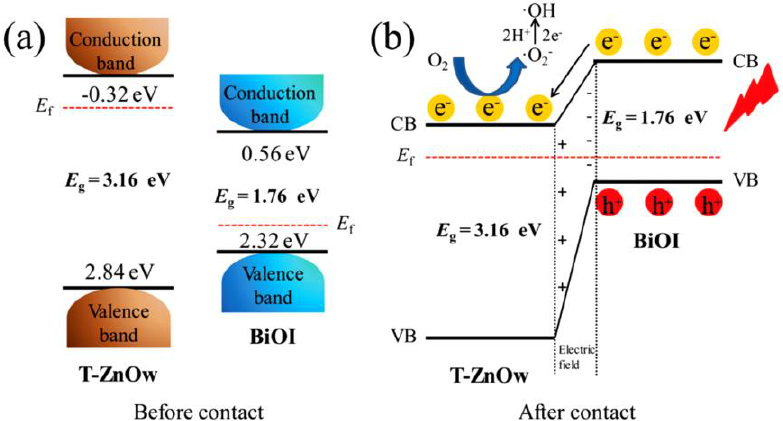
Figure 11. Schematic diagrams of the energy levels of T-ZnOw and BiOI ( a ) before contact and ( b ) after the formation of a p – n BiOI/T-ZnOw heterojunction and possible photocatalytic degradation mechanism under visible light irradiation. Reproduced with permission from [149]. Copyright 2022 The Royal Society of Chemistry.